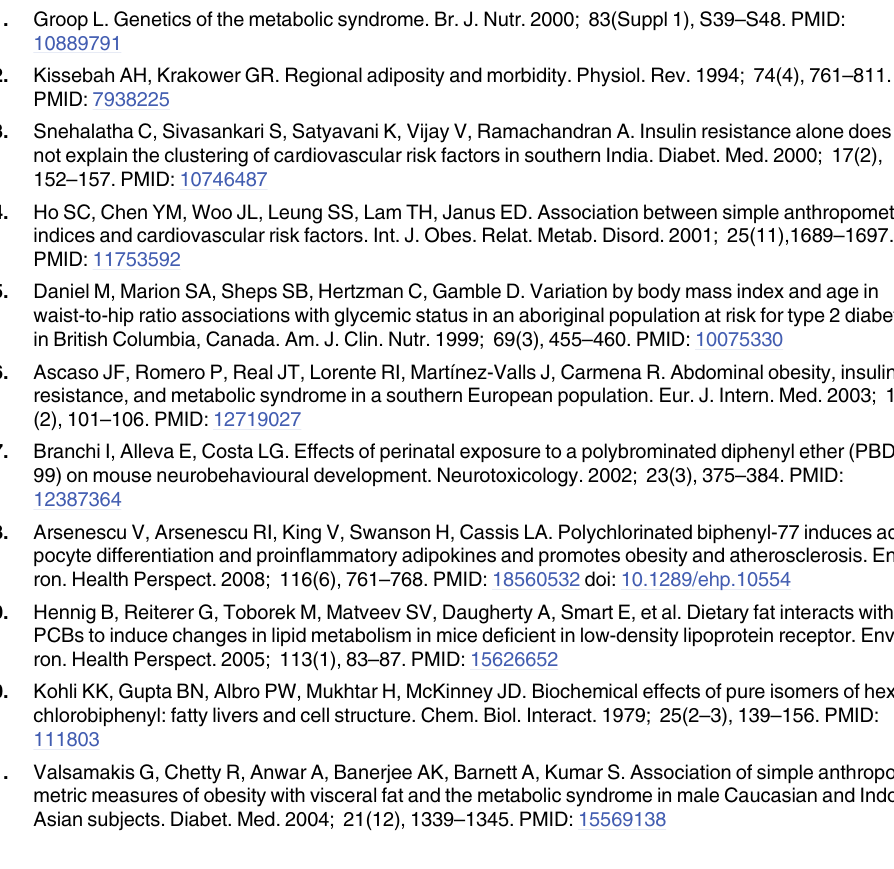
S1 Table. Pearson correlation coefficients among abdominal obesity components, and serum PCDD/F levels (Men). S2 Table. Pearson correlation coefficients among abdominal obesity components, and serum PCDD/F levels